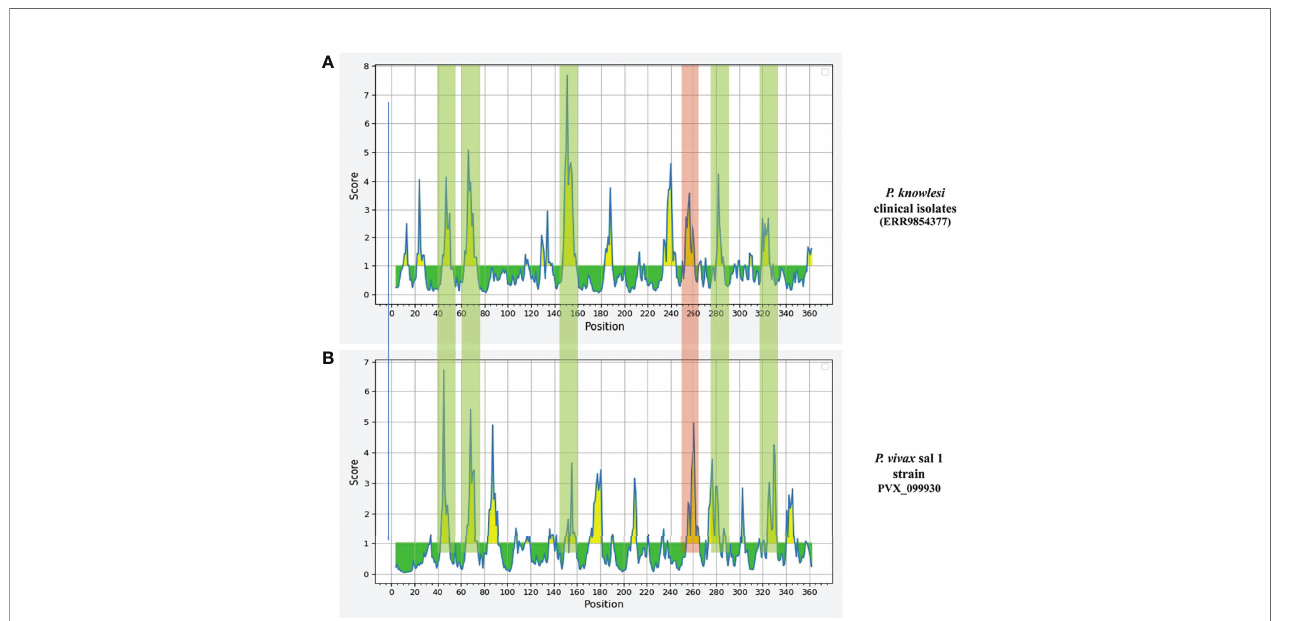
FIGURE 5 | The graphs ( A P. knowlesi and B P. vivax ) are obtained from epitope prediction software IEDB. The graph represents the possible epitope region in RhopH2 protein. The peaks in graph show the possible epitope region in RhopH2 protein. The highlighted part represents the overlapping of the peaks in P. knowlesi and P. vivax. This indicates there is possibility of epitopes which have one or more common amino acids. The peak highlighted in red regions shows a 100% conserved amino acid sequence in all three clusters of P. knowlesi clinical isolate and P. vivax .